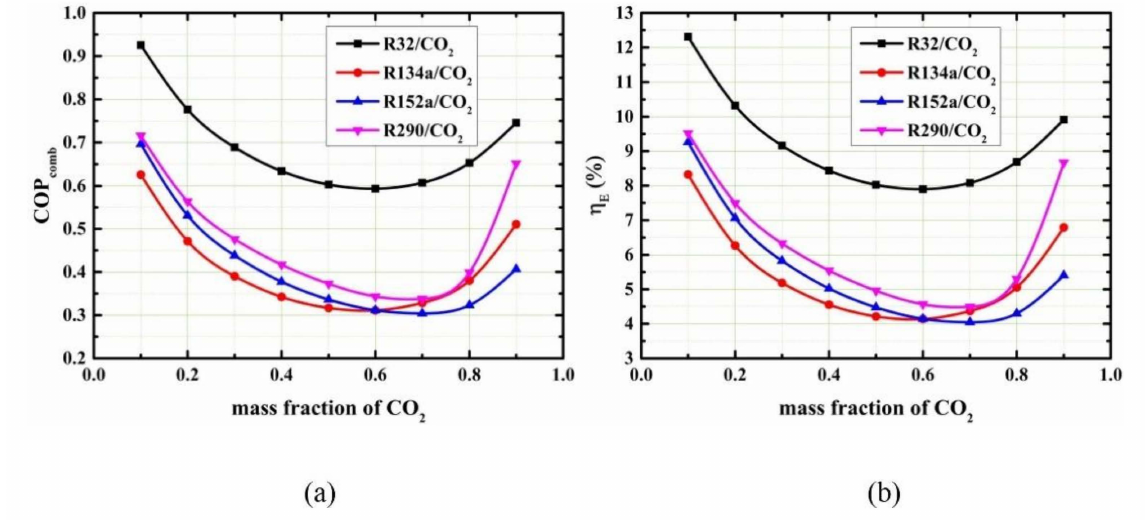
Figure 26. The effect of the zeotropic mixture and mass fraction of CO 2 on the system. ( a ) COP comb ; ( b ) η E . Reprinted from ref. [74], Copyright (2020), with permission from